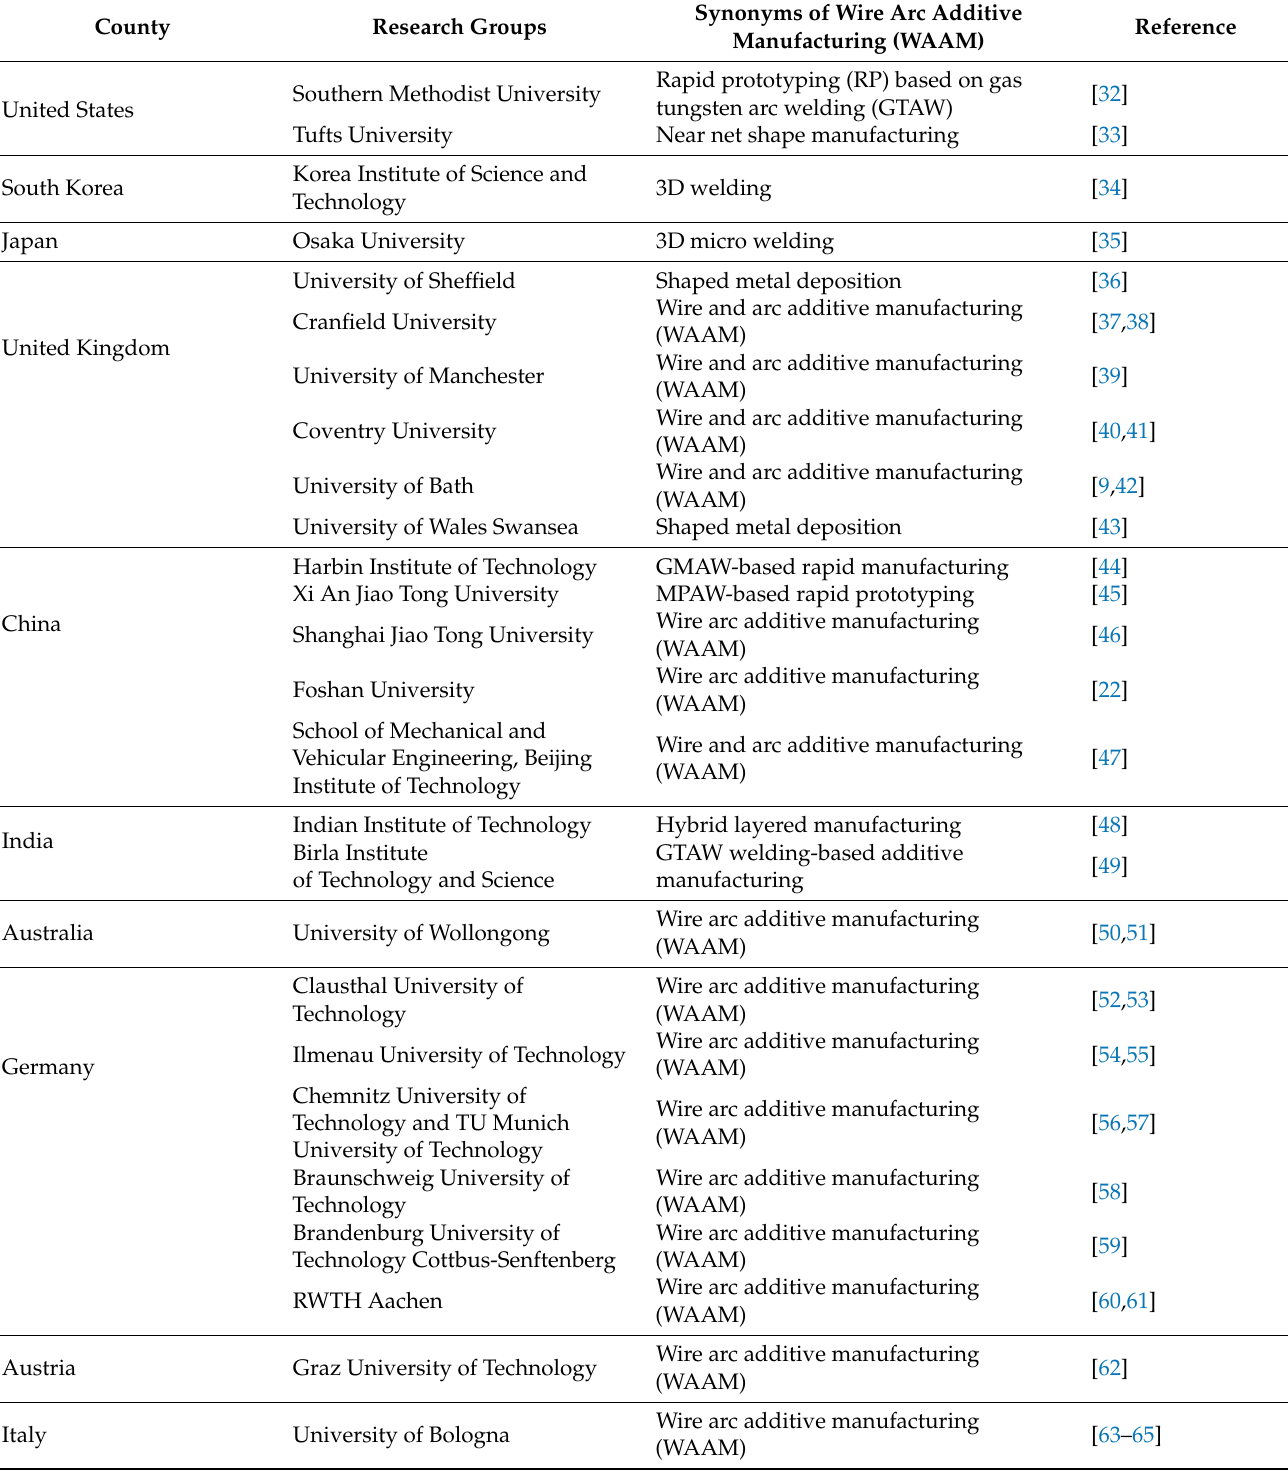
Table 1. Main research groups working on WAAM (modified)